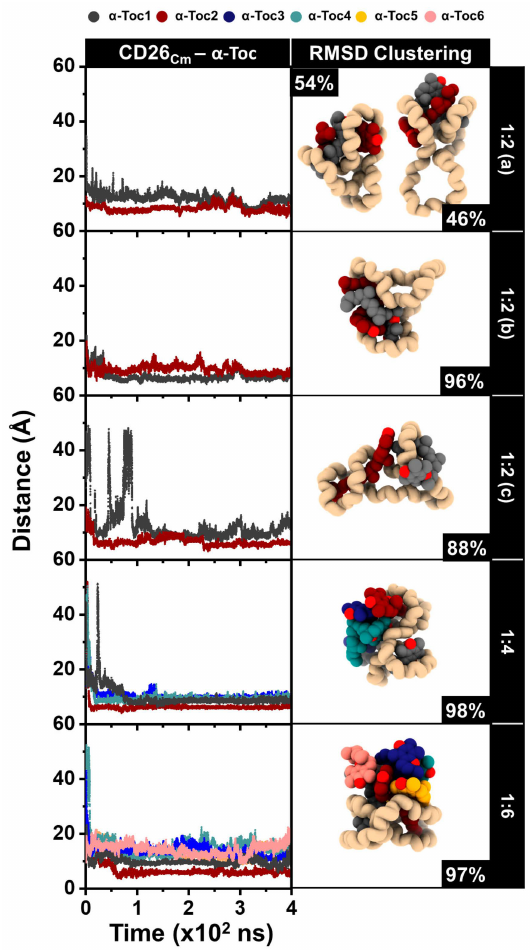
Figure 2. ( Left ) The distances between the C m of CD26 and α -tocopherol and ( right ) RMSD clustering of the 1:2 ( a ), 1:2 ( b ), 1:2 ( c ), 1:4, and 1:6 complexes. The difference between models 1:2 ( a – c ) is α - tocopherol’s beginning position arrangement. Figure 3 highlights the cyclodextrin conformations of CD1 and CD2 in the 2:1 (a), 2:1 (b), and 2:1 (c) systems. The two CD molecules in the 2:1 (a) and 2:1 (b) systems move closer to each other and entrap the α -tocopherol, as can be seen from the distance values of 6–16 Å. Similarly, in the 2:1 (c) system, both CD1 and CD2 are able to tightly